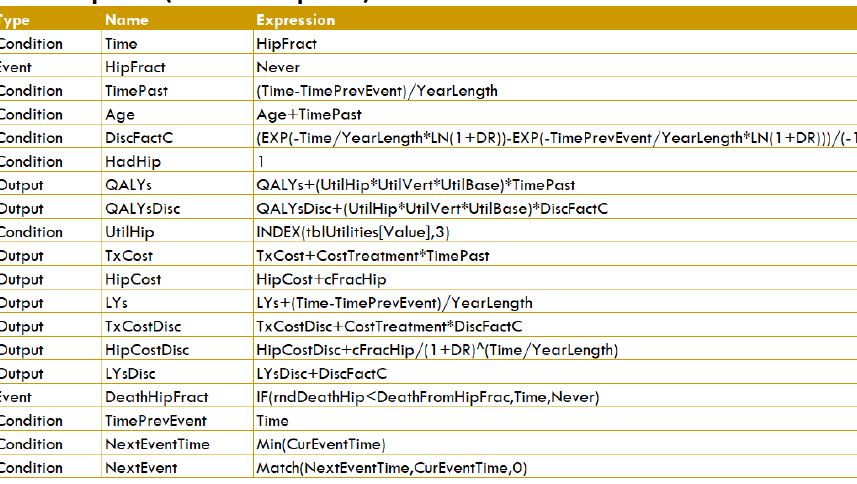
Figure A12. Table for the ‘hip fracture’ event in